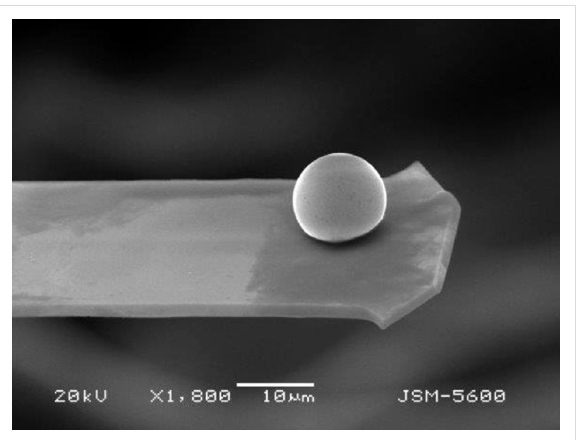
Figure 4: Scanning electron microscopy image of a mercury drop at- tached to a tipless cantilever obtained with a JSM5600-LVmicroscope.